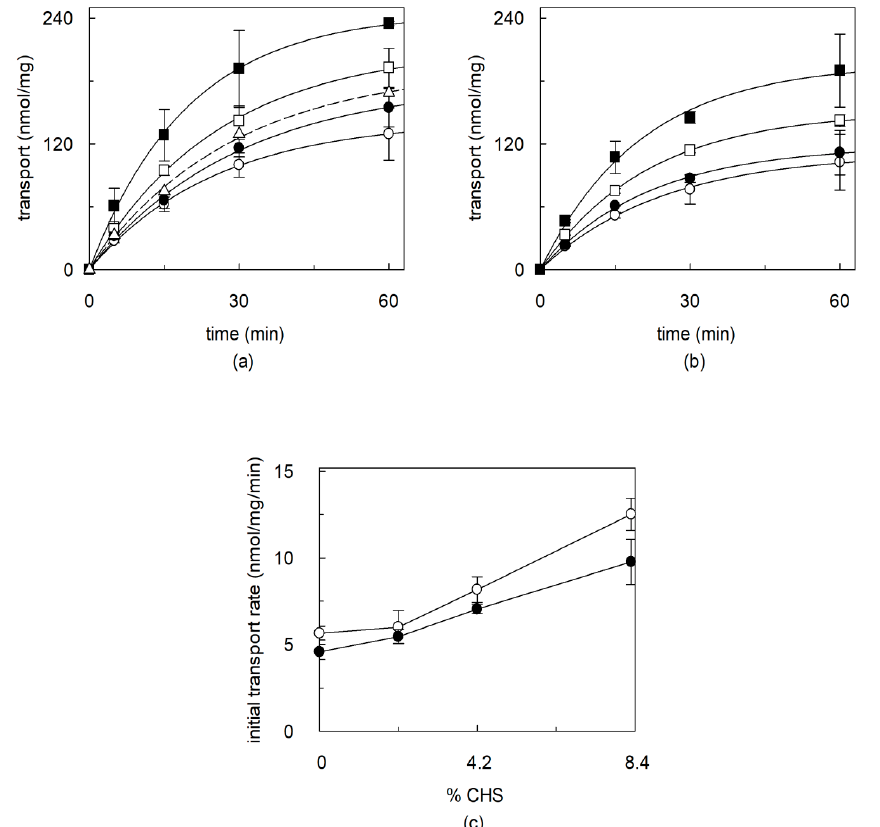
Figure 3. Effect of increasing cholesterol (CHS) concentrations on OCTN1 mediated transport of TEA and acetylcholine. The recombinant OCTN1 was reconstituted in liposomes as described in Section 4.5. except that ( a and b ) proteoliposomes batches used for each time course experiment were reconstituted in the presence of 0 ( ○ ), 2.1 ( ● ), 4.2 ( □ ), 8.3 ( ■ ) % CHS (corresponding to 0, 21, 42 and 83 µg CHS/mg total lipids, respectively). ( a ) Transport was started adding 0.1 mM [ 14 C]-TEA ( b ) or 0.1 mM [ 3 H]-acetylcholine, at time zero to proteoliposomes and stopped at the indicated times as described in Section 4.7. Time course data